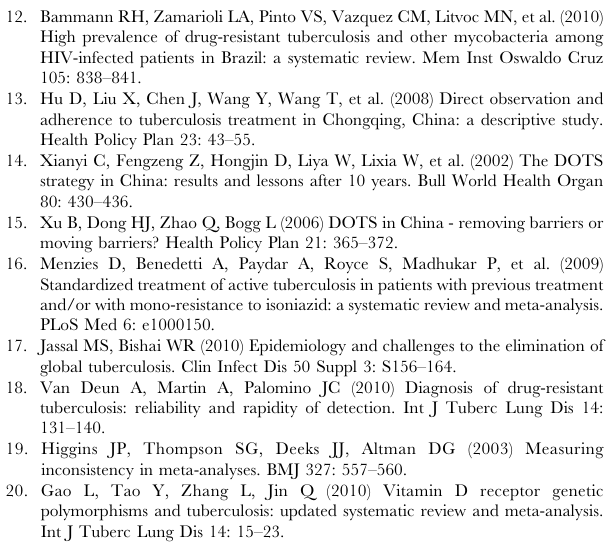
Figure S3 Forest plot of the meta-analysis on any drug resistance in previously treated cases. (‘‘*’’ in the figure means studies reported by the same publication). Figure S4 Funnel plot of the meta-analysis on any drug resistance in previously treated cases. Table S1 Included and excluded articles after full-text evaluation. Table S2 Detailed information of the included studies.